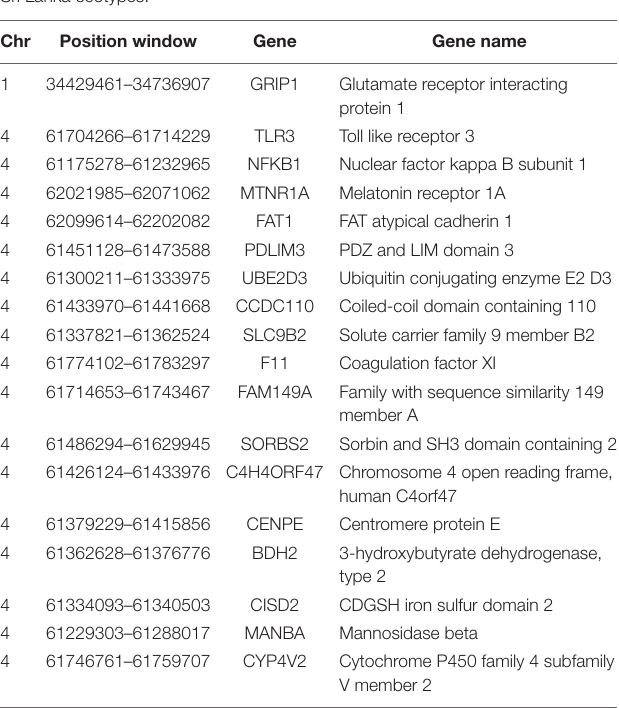
TABLE 4 | List of genes in the identified putative selection signatures among Sri Lanka ecotypes. Chr Position window